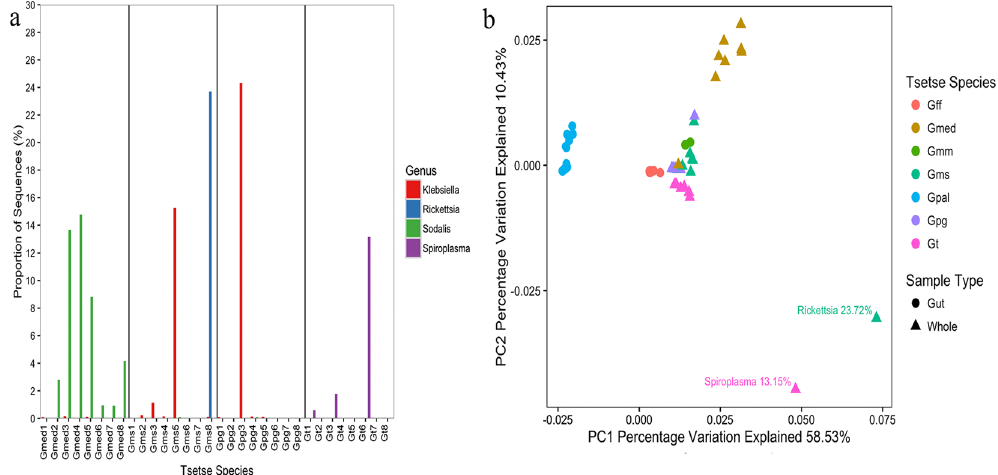
Figure 1. ( a ) Relative abundance of Klebsiella , Rickettsia , Sodalis , and Spiroplasma in whole wild tsetse flies. (Gmed: G . medicorum ; Gms: G . morsitans submorsitans ; Gpg: G . p . gambiensis ; Gt: G . tachinoides ). ( b ) Weighted Unifrac Principal Component Analysis of 16 S rRNA gene MiSeq data. Each data point represents an individual tsetse fly and is coloured according to Glossina species. Convergent evolution between the primary endosymbiont Wigglesworthia and its host due to direct vertical transmission generates a tsetse species-clustering pattern that simplifies the detection of emergent taxa such as Spiroplasma and Rickettsia . All gut samples originated from the study by Aksoy et al . in 2014, and whole samples were collected in Burkina Faso. (Gmm: Glossina morsitans morsitans ; Gff: G . fuscipes fuscipes ; Gmed: G . medicorum ; Gms: G .